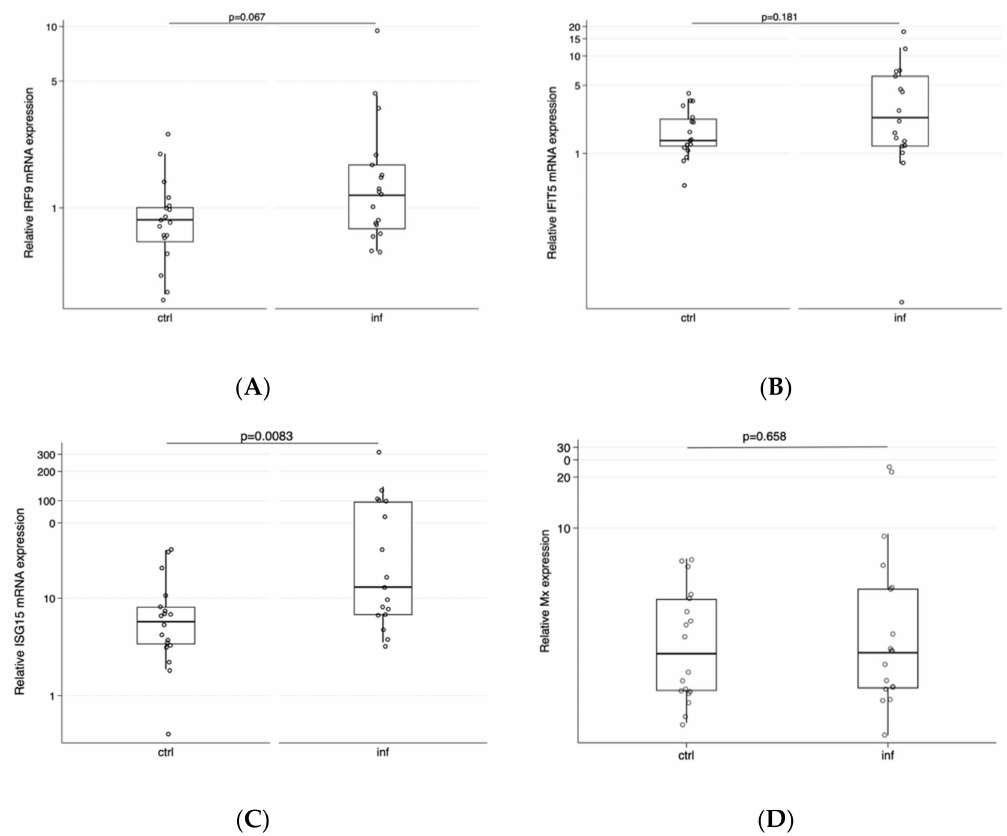
Figure 2. Relative mRNA expression of ( A ) IRF9, ( B ) IFIT5, ( C ) ISG15, and ( D ) Mx in cells obtained from non-infested (ctrl, n = 3) and lice-infested (inf, n = 3) fish followed over a period of six days in vitro after SAV-3 infection. Bars represent the normalized expression in cells obtained from di ff erent individuals at di ff erent time points relative to cells not infected with the virus using the ddCt approach and median (25 / 75 percentile) and 90% percentile for whiskers; p -values for di ff erences between controls (ctrl) and infected (inf) are given above the